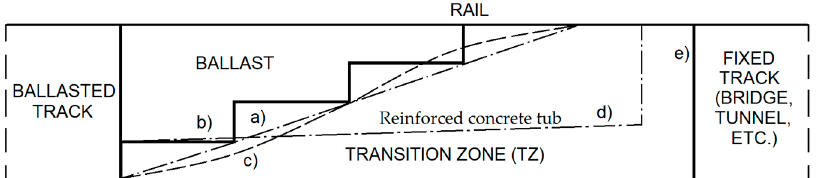
Figure 1. Shapes of elements for elimination of forces in the transition zones, optimized: ( a ) Linear; ( b ) Stepped; ( c ) Cosine; ( d ) Reinforced concrete tub; ( e ) Non-optimized.